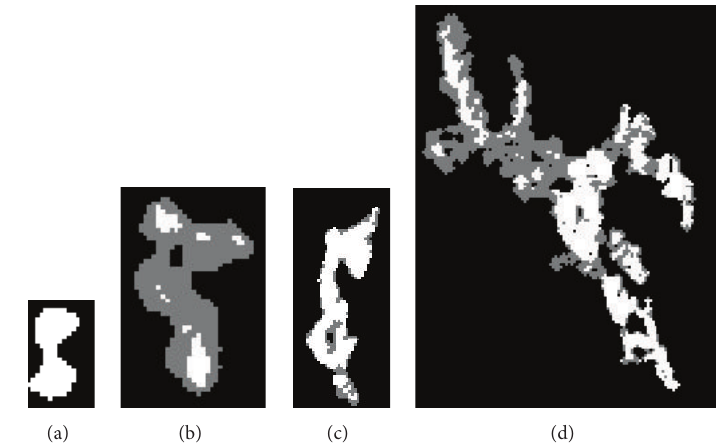
Figure 4: Four different spatiochromatic patterns. (a) Type 1; (b) Type 4; (c) Type 2; (d) Type 3.